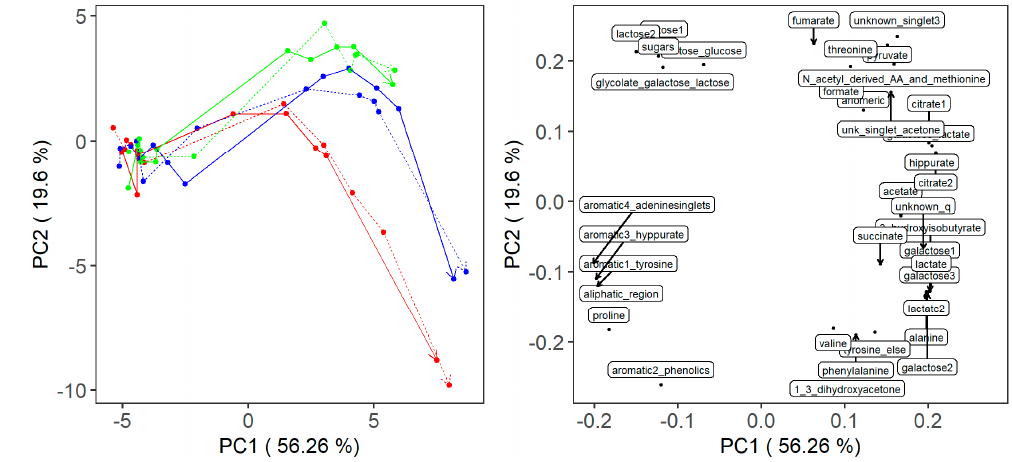
Figure 3. Principal component analysis of selected metabolite concentrations. Left: score plot with fermentation time denoted by trajectories where the arrows mark the 24 h samples. Starter cultures are colored as follows: L. delbrueckii ssp. bulgaricus red, S. thermophilus green and their combination in blue. Milk treated at 99 °C (LT) is represented with a full line, while milk treated at 105 °C (HT) is represented with a dotted line. Right: loading plot. Arrows link the loading plot point to the interval name when excessive clustering is present.